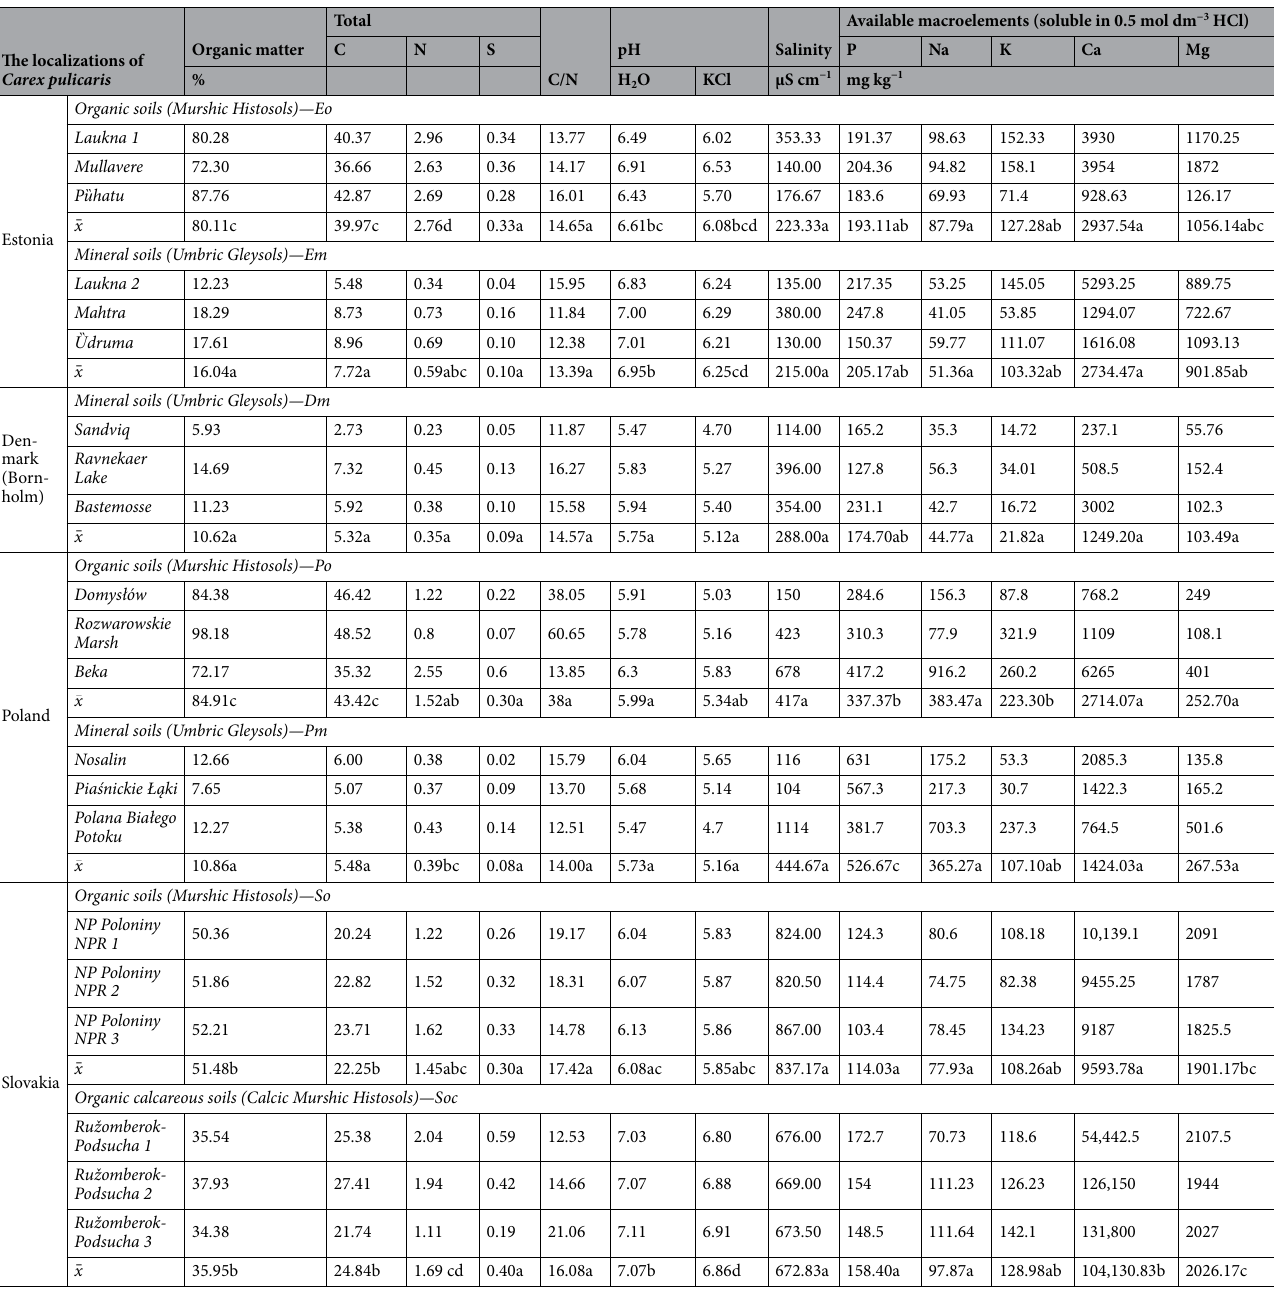
Table 2. Basic soil properties and macronutrient